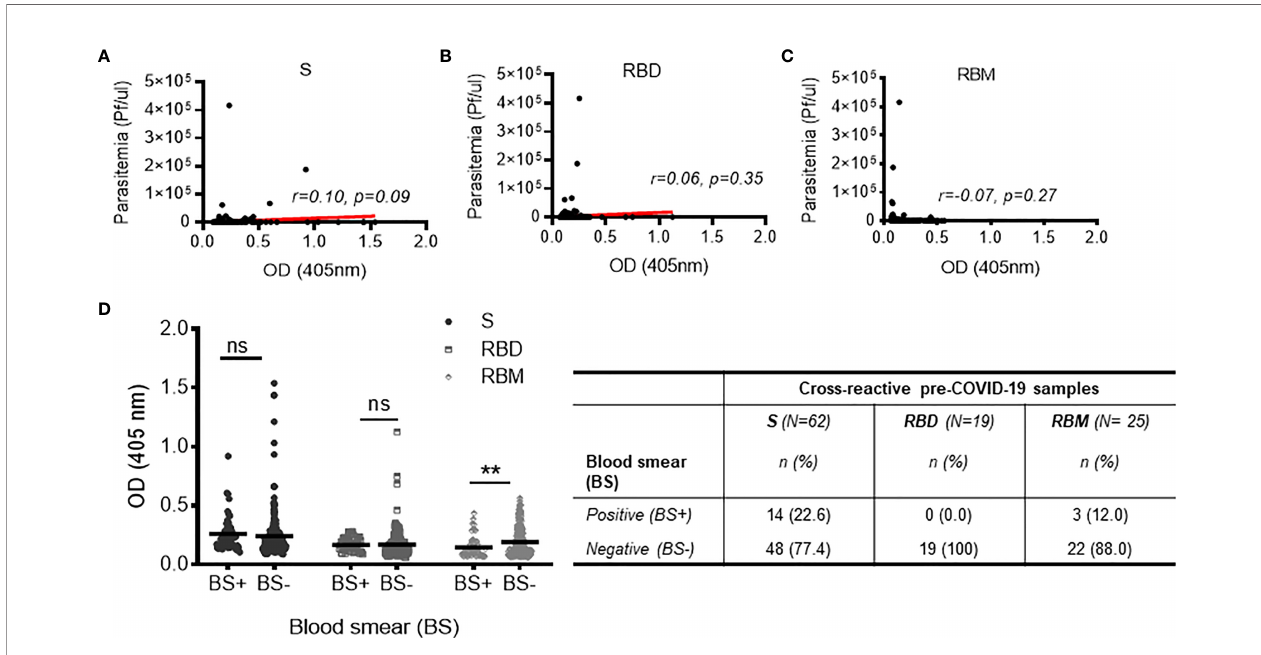
FIGURE 7 | Relationship between cross-reactivity against S, receptor-binding domain (RBD), and receptor-binding motif (RBM) and active malaria infection among pre-COVID-19 donors. (A – C) Non-signi fi cant correlations of cross-reactive antibodies to S, RBD, or RBM with present malarial infection (i.e., Plasmodium falciparum parasitemia in the pre-COVID-19 donor groups). Red lines indicate the best- fi t relationship between data points. p - and R-values were calculated using the two-tailed Spearman ’ s rank correlation tests. (D) The graph shows no signi fi cant variation in cross-reacting antibodies against S and RBD in pre-COVID-19 samples with (blood smear positive (BS+)) or without (blood smear negative (BS − )) present malarial infections; on the other hand, the high level of cross-reactive antibody against RBM was strongly associated ( p < 0.01) with the absence of malarial infection (BS − ). The table shows the proportions of BS+ or BS − cross-reactive samples against S, RBD, and RBM. N, total number of cross-reactive samples; n, number of BS+ or BS − cross-reactive samples. Comparisons of the mean optical density (OD) for BS+ and BS − sample groups were made using the unpaired t-test. ** p < 0.01; ns, not signi fi cant.